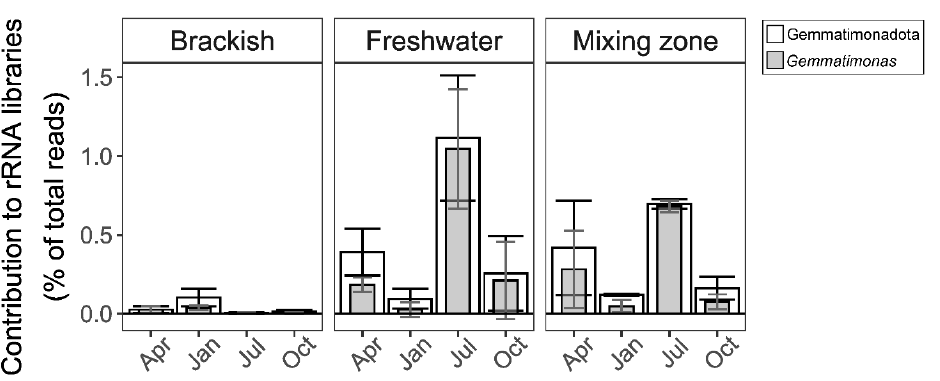
Figure 9. Gemmatimonadota rRNA reads recorded in the Gulf of Gda´nsk (Baltic Sea) and the estuary of the Vistula River. The figure shows the percentage of reads associated with Gemmatimonadota (white), as well as the genus Gemmatimonas (gray). The salinity of brackish waters was ≥ 7‰, that of freshwater was <0.5‰, and that of the mixing zone was about 3.5‰. The data used to generate the figure were published in [69].